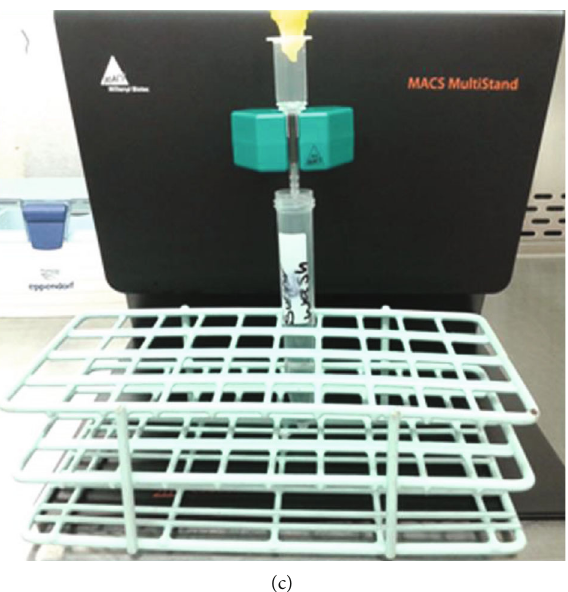
Figure 3: (a) The con fi rmatory fl ow cytometry graph of the magnetic sorted GMSC homogeneous CD146-positive population, which optimized the signal to 55% purity. (b) The fl ow cytometry graphs of the negative control isotype, which showed no signal of the CD146 marker. (c) The magnetic sorting